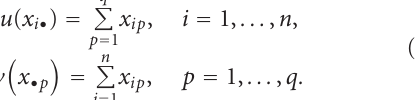
algorithm, particle swarm optimization algorithm,